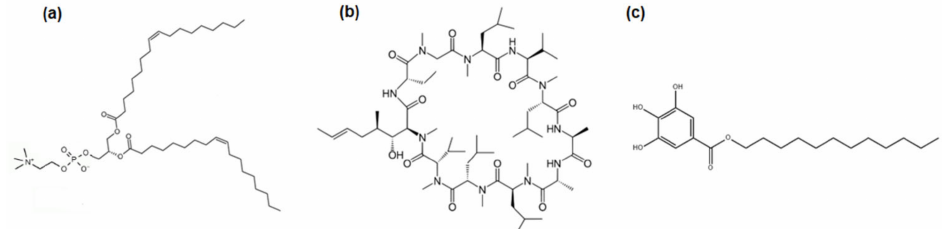
Figure 1. Structure of 1,2-dioleoyl- sn -glycero-3-phosphocholine, DOPC ( a ), cyclosporine A, CsA ( b ), and lauryl gallate, LG ( c